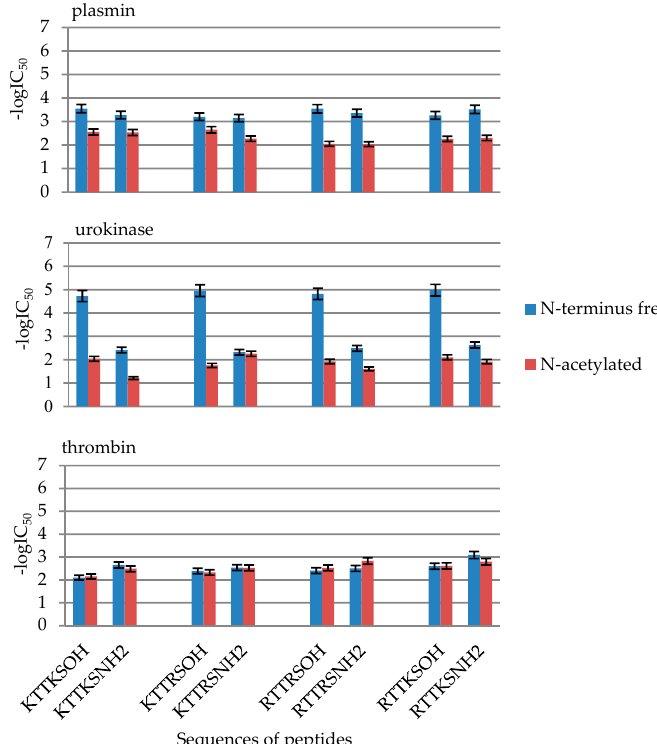
Figure 6. Influence of the introduction of N-terminal acetyl group in the synthetized peptides on plasmin, urokinase and thrombin inhibition. Inhibition values in the form of -logIC 50 from Table